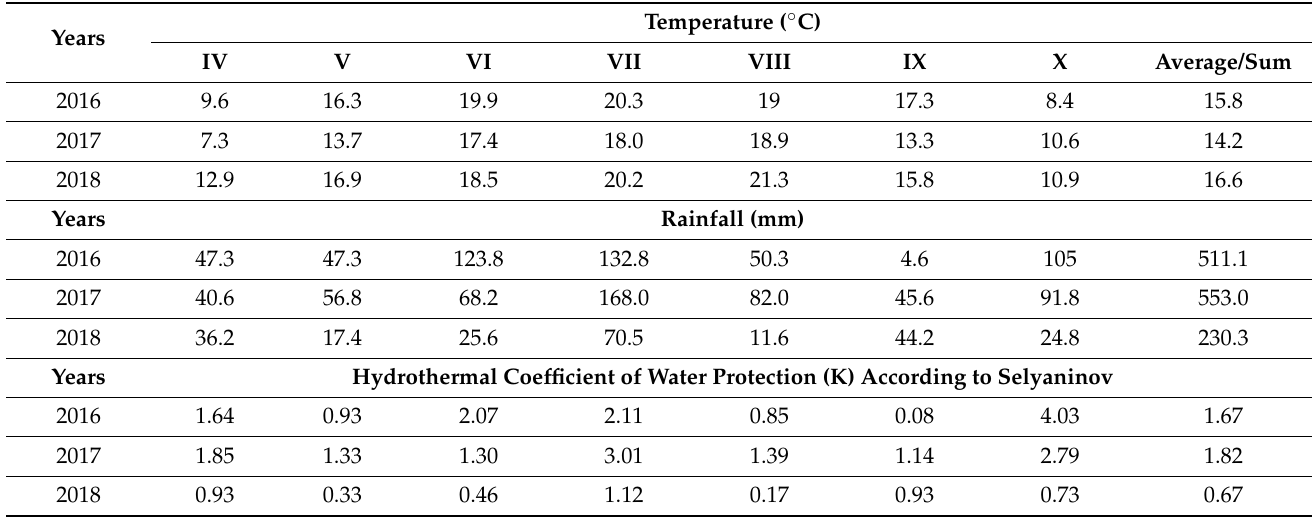
Table 2. Average monthly air temperatures and monthly total precipitation for the growing